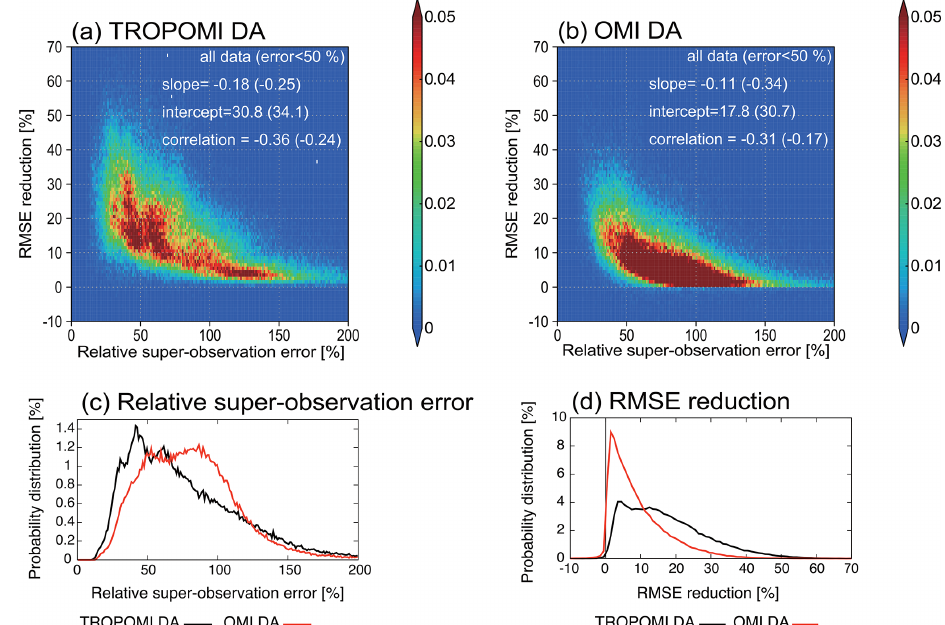
Figure 3. Two-dimensional (2-D) histogram (%) as a function of relative super-observation errors (%) and root-mean-square error (RMSE) reductions (%) for tropospheric NO 2 column made to data assimilation (DA) (a, b) obtained from Tropospheric Monitoring Instrument (TROPOMI) DA (a, c) and Ozone monitoring Instrument (OMI) DA (b, d) . The values in the top panels are regression coefficients, intercepts, and correlation coefficients between relative super-observation errors and RMSE reductions against assimilated observations by DA on the grid scale. The values in brackets were calculated using data with relative super-observation errors of < 50%. One-dimensional (1-D) histograms as a function of relative super-observation errors (c) and RMSE reductions (d) are exhibited in the bottom row. The black and red lines are taken from TROPOMI DA and OMI DA, respectively.